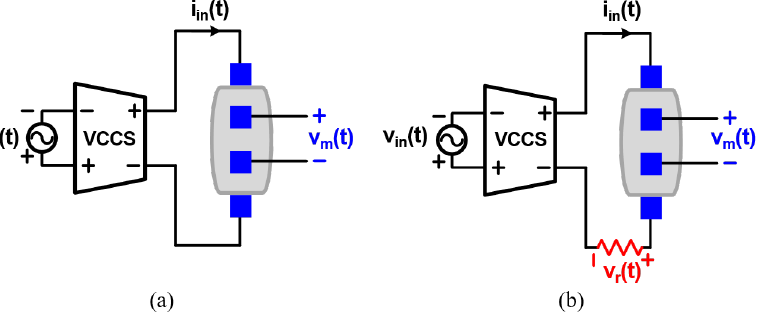
Figure 2. Impedance measurement structures ( a ) without and ( b ) with a reference resistor connected in series with the target